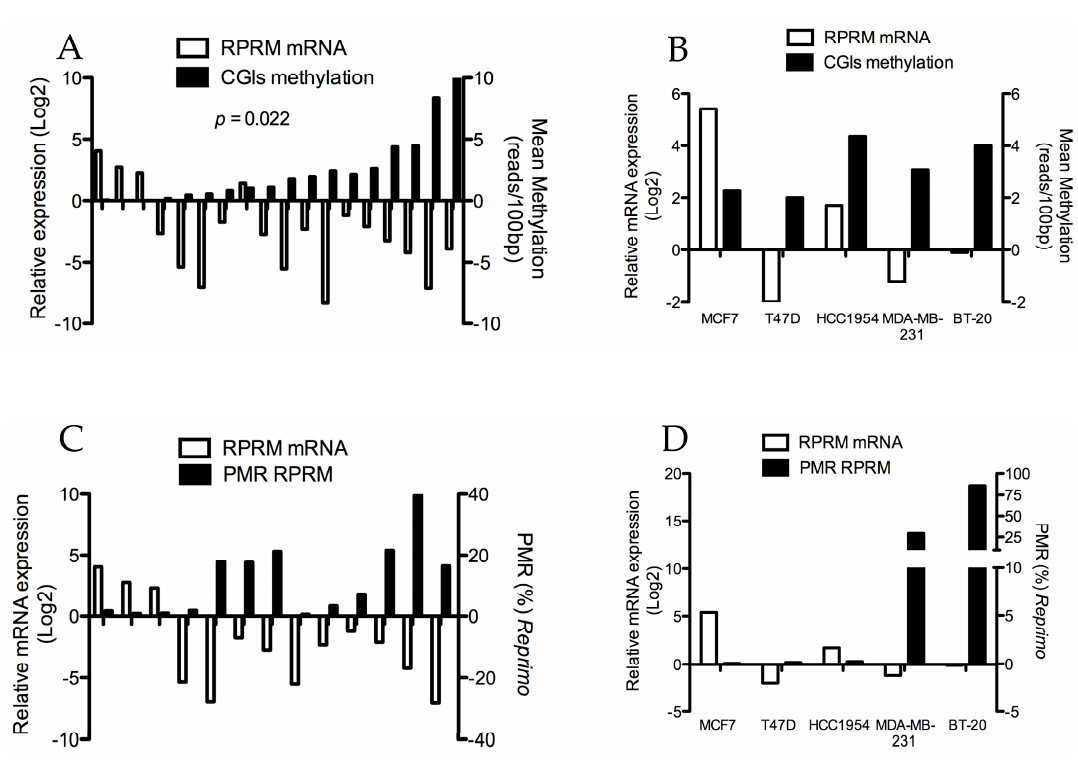
Figure 3. A Spearman correlation analysis between mRNA expression and methylation of RPRM CGIs of primary breast tumors and cell lines. ( A ) A significant inverse correlation was observed between mRNA expression and methylation of RPRM CGIs in paired clinical samples ( n = 18) ( p < 0.05); ( B ) meanwhile, in the BC cell lines, the Spearman correlation was not significant ( p = n . s ); ( C ) correlation between qMSP and qPCR assay in paired clinical samples ( n = 13) was not significant ( p > 0.05); ( D ) in cancer cell lines, an increase of percentage-methylated relative (PMR) RPRM was observed frequently with a downregulation of RPRM mRNA in ER α -negative cells; BT-20 and MDA-MB-231. In contrast, MCF7 shows upregulation of RPRM mRNA without methylation of the RPRM promoter region. However, no significant correlation was observed ( p > 0.05).